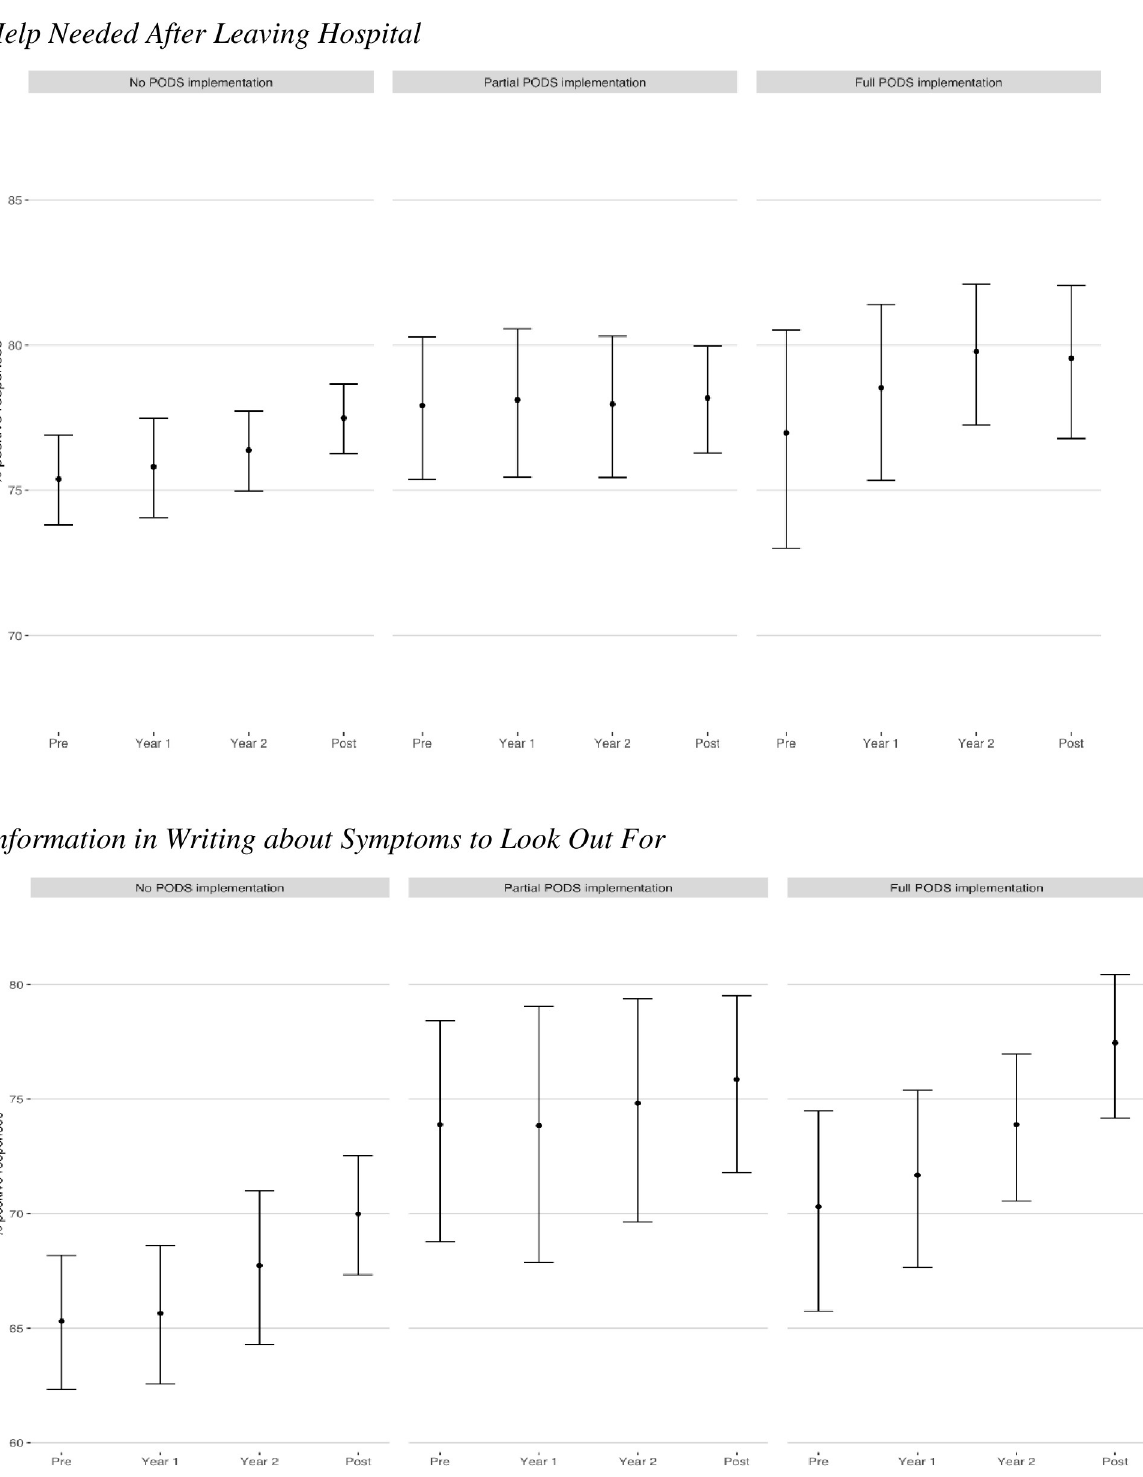
Fig 1. Percentages of positive patient experience by cohort over time, accounting for site level clustering, using GEE.